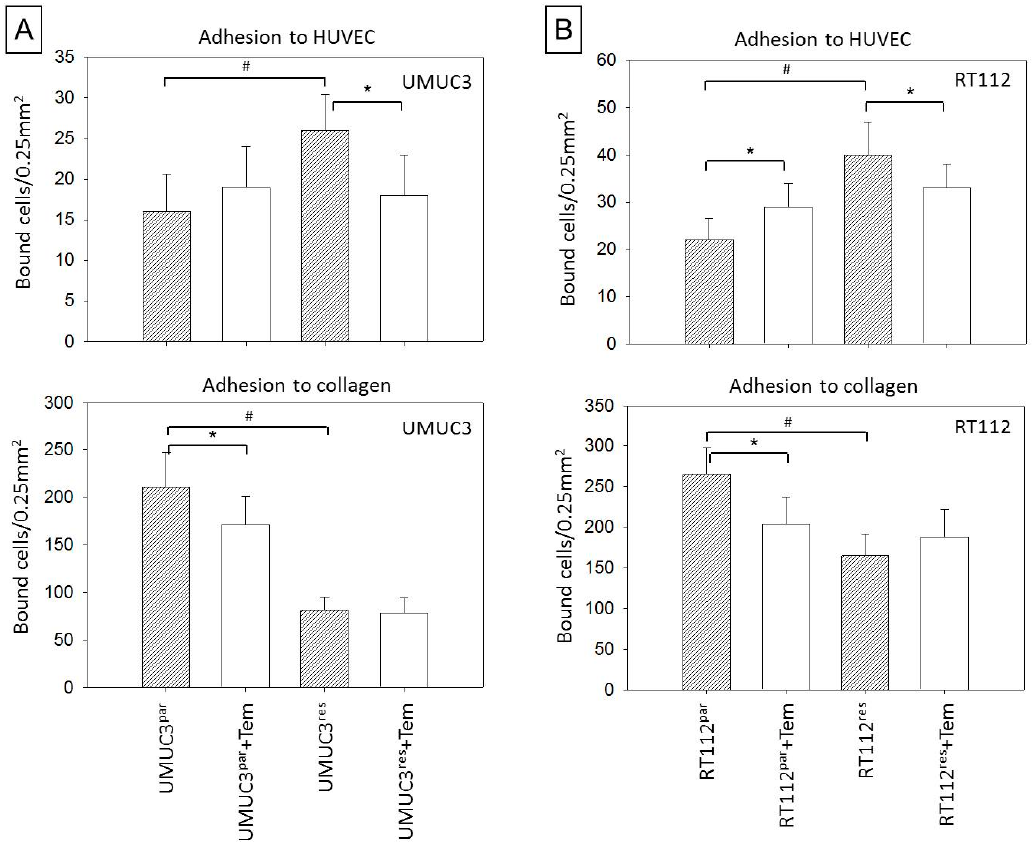
Figure 5. Adhesion of parental and temsirolimus-resistant ( A ) UMUC-3 and ( B ) RT112 to endothelium HUVEC (upper) and collagen (lower). Tumor cells were treated with 10 nmol / mL temsirolimus for 72 h. Controls remained untreated. Mean number of adherent tumor cells from five fields after 2 h (HUVEC) or 1 / 2 h (collagen) incubation. Bars indicate standard deviation (SD), * indicates significant di ff erence to corresponding control, # indicates significant di ff erence to parental control, p ≤ 0.05. n = 5. Migration properties di ff ered between parental and resistant tumor cell populations as well.